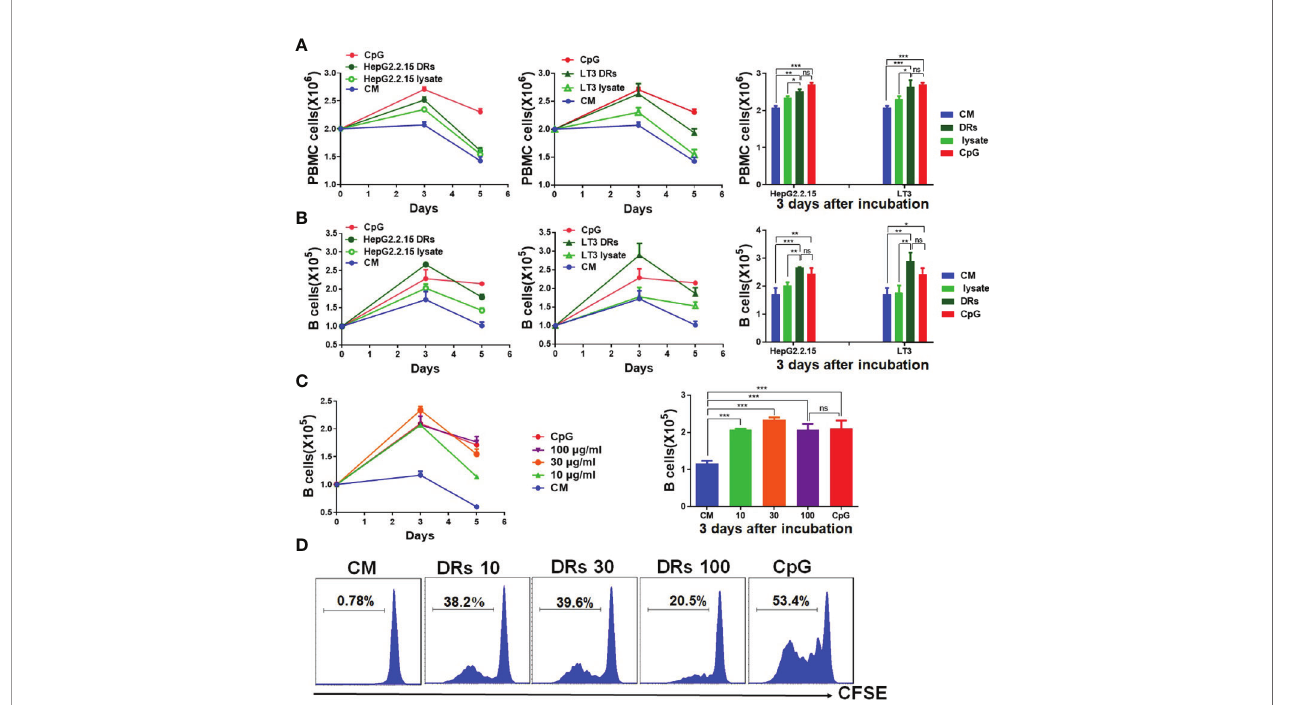
FIGURE 1 | DRibbles induced human B cells proliferation in vitro . (A) PBMCs isolated from the healthy donors were incubated with DRibbles (30 m g/ml), which were derived from HepG2.2.15 or LT3 cell line, and corresponding tumor cell lysates (30 m g/ml total proteins) for 1 to 5 days. Absolute numbers of PBMCs (A) and B cells (CD19 + cells among PBMCs, (B) were measured by fl ow cytometric analysis. (C) PBMCs co-incubated with different concentrations (0,10, 30, or 100 m g/ml) of HepG2.2.15 DRibbles for 3 days, absolute numbers of B cells (CD19 + cells among PBMCs) were measured by fl ow cytometric analysis. (D) PBMCs were labeled with CFSE and incubated with HepG2.2.15 DRibbles for 3 days, stained with APC-labeled anti-human CD19 mAb and then analyzed by fl ow cytometry. CM indicated complete medium. Results are representative of three independent experiments from three different healthy donors. ns, P > 0.05, * p < 0.05, ** p < 0.01, *** p <